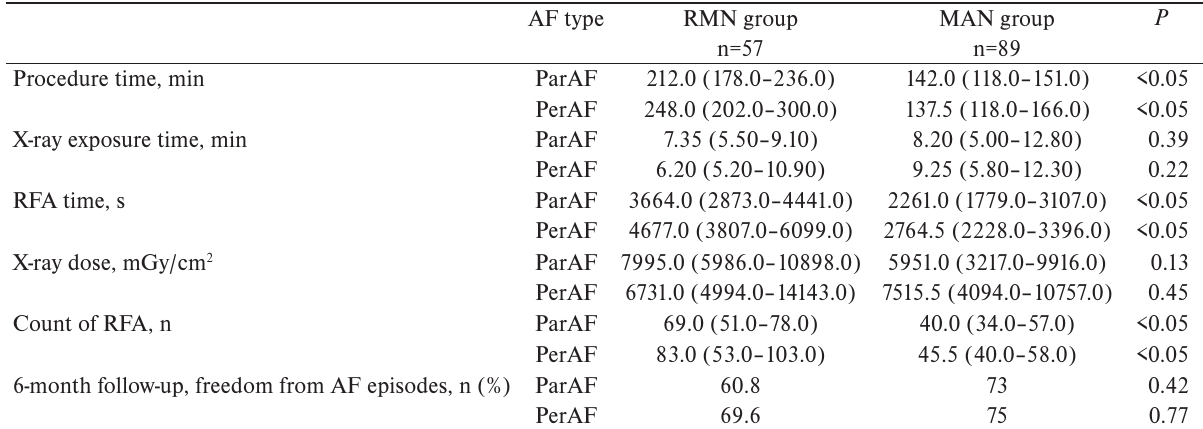
Table 2. Procedural